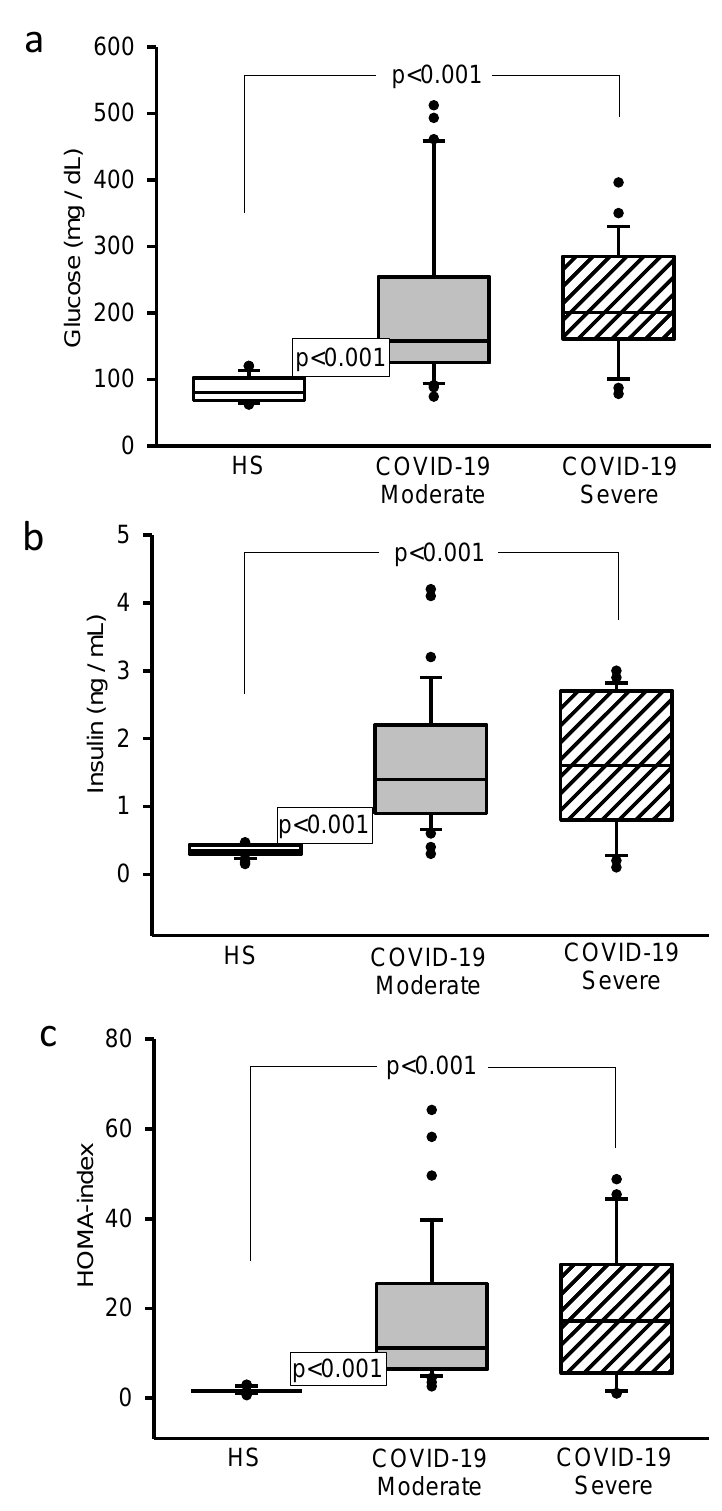
Figure 1. ( a ) The values of glucose significantly increased in the moderate and severe COVID-19 patients in comparison with HS. ( b ) Insulin had a significant increase in the moderate and severe COVID-19 patients in comparison to HS. ( c ) The HOMA index significantly increased in the moderate and severe COVID-19 patients in comparison with HS. Abbreviations: HS = healthy subjects, HOMA index = marker of insulin resistance which if the values are greater than 2.5 is an indication of insulin resistance.